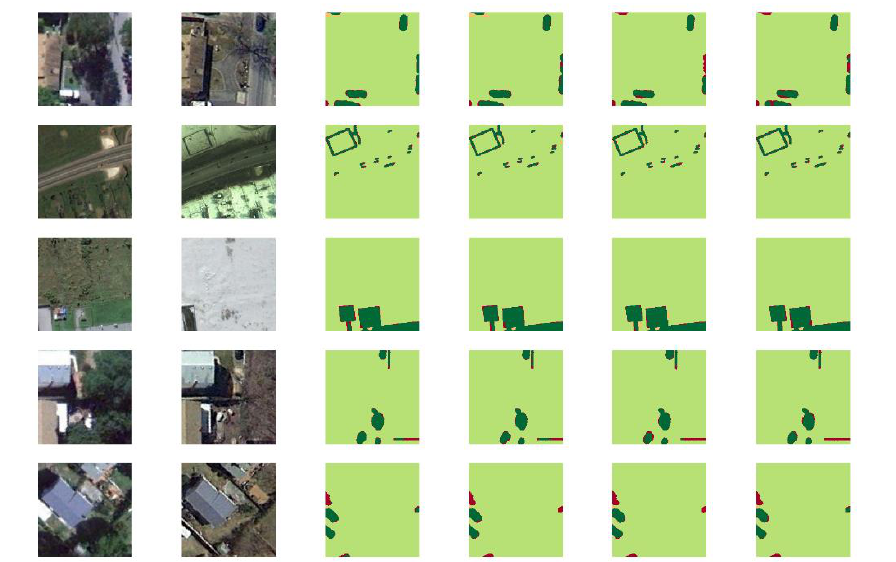
Figure 9: Examples of change masks for various models. The color scale is the same as in Figure 9. From left to right the models are: (a) the UNet++ trained with BCE Dice loss and data augmentation, (b) the UNet++ trained with Lovasz Hinge loss deep supervision and data augmentation, (c) the UNet trained with BCE Dice loss and data augmentation and (d) the UNet trained with Lovasz Hinge loss and data